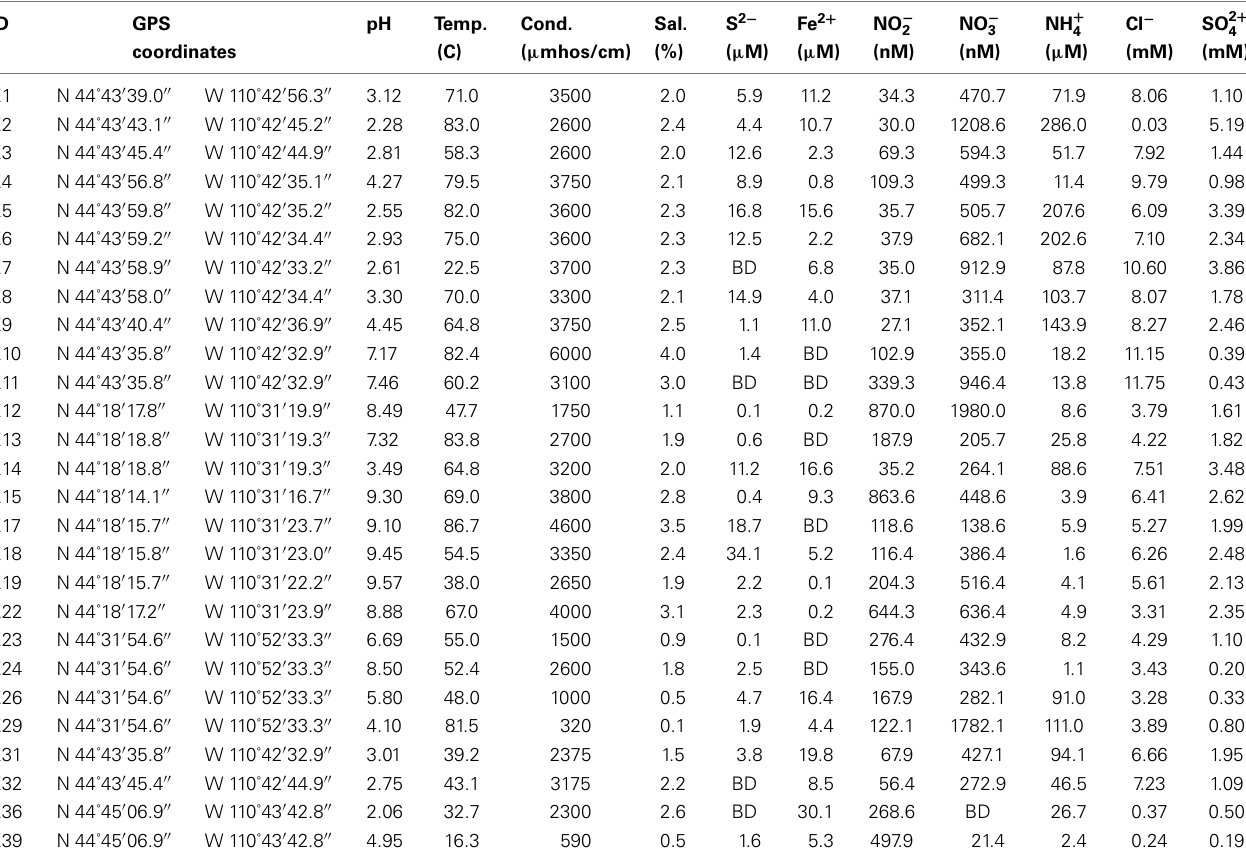
Table 1 | Location and aqueous chemistry associated with geothermal mat and sediment samples. ID GPS